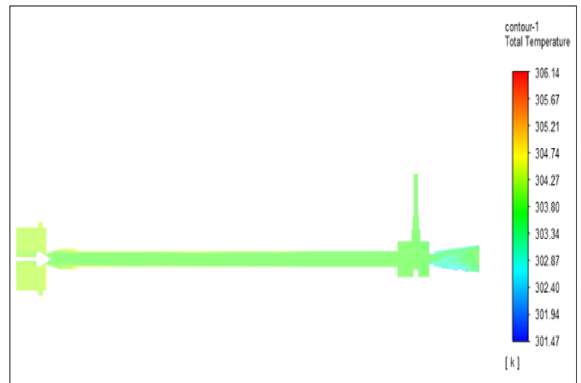
Figure 3. Stainless steel at 2 bar.